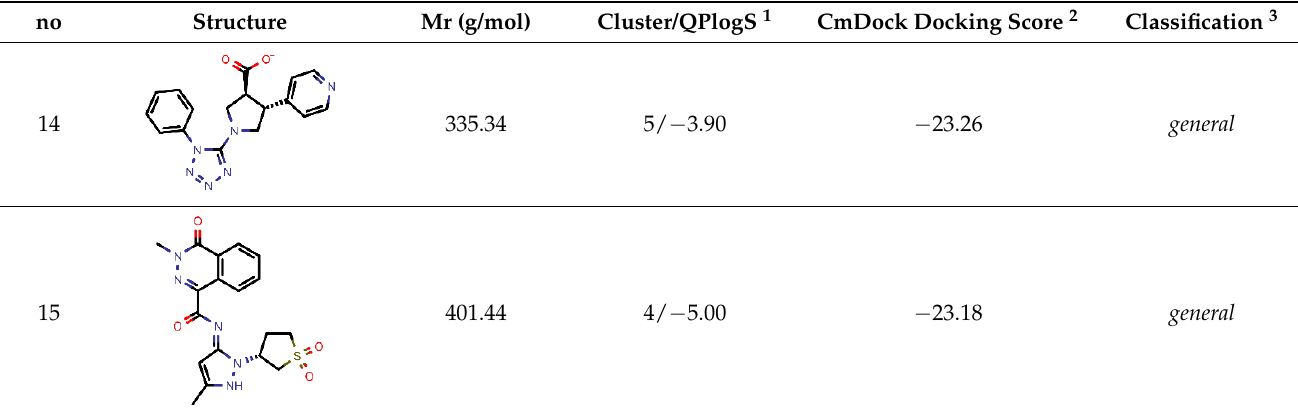
1 QPlogS Predicted aqueous solubility, log S. S in mol dm − 3 is the solute concentration in a saturated solution in equilibrium with the crystalline solid ( recommended value range by QuickProp is between –6.5 and – 0.5); 3 CmDock INTER-molecular docking score.; 3 As per NeuralNet model.